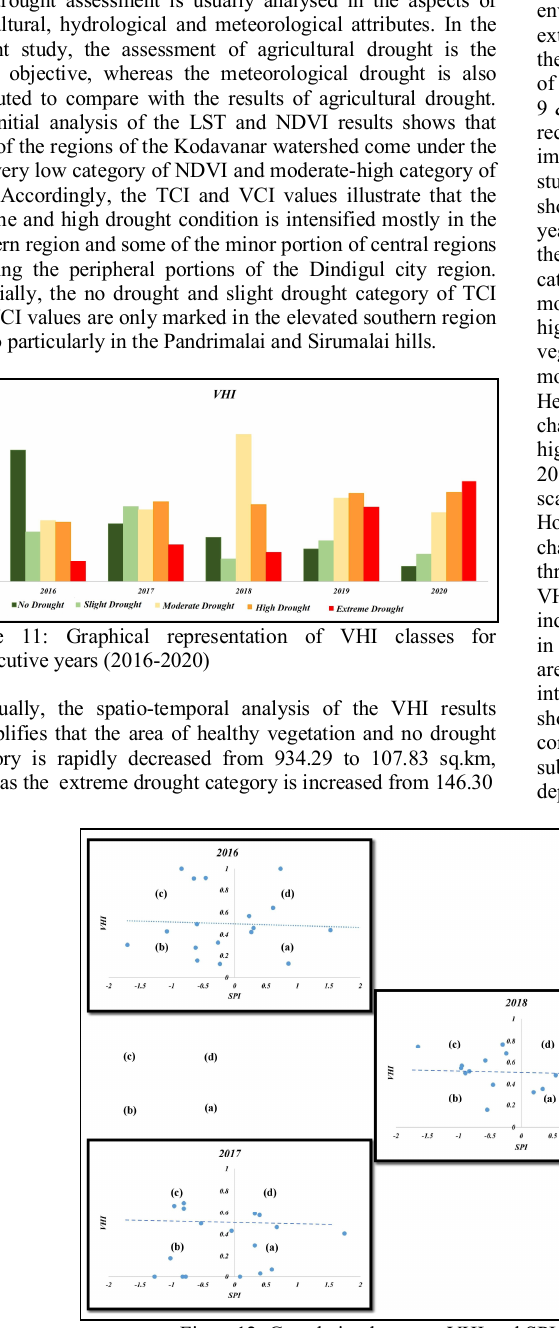
Figure12: Correlation between VHI and SPI for consecutive years